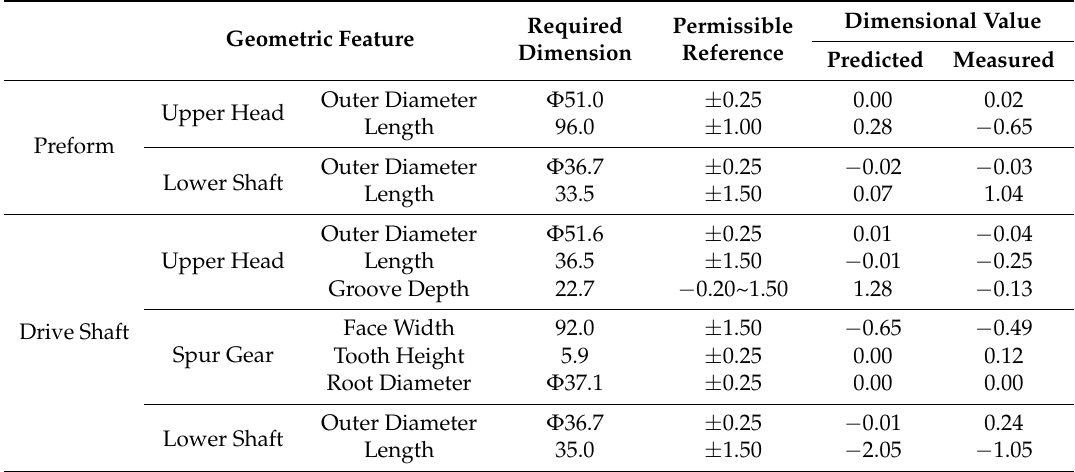
Table 3. Dimensional accuracy required for preform and drive shaft (unit: mm).